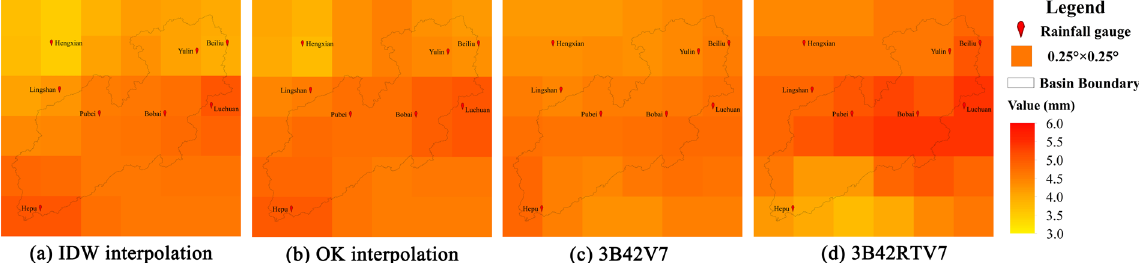
Figure 2. The spatial distribution of 9-year mean daily precipitation over the Nanliu river basin, derived from ( a ) IDW interpolation, ( b ) OK interpolation, ( c ) 3B42V7 and ( d ) 3B42RTV7. The maps were generated using ArcGIS10.1